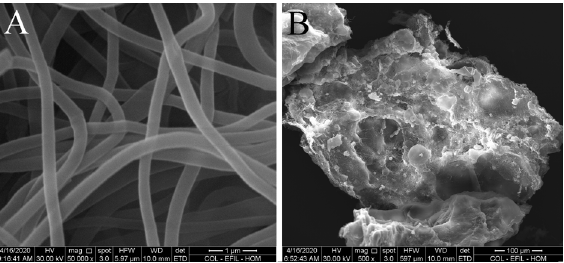
Figure 3. SEM image of electrospun collagen nano/submicrofibers ( A ; mag. 50,000×) and collagen particles prepared via homogenisation of collagen electrospun layers ( B ; mag. 500×).